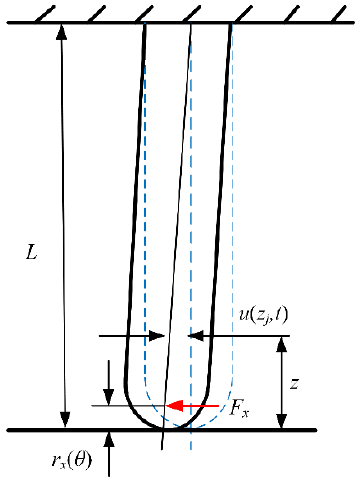
Figure 4. Schematic diagram of the tool deformation.